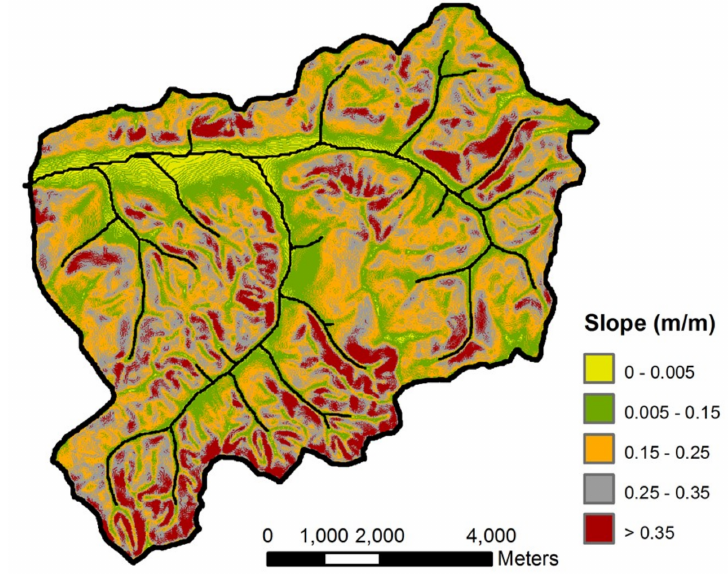
Figure 4. Distribution of ground slopes in the Komarovsky